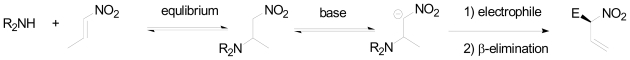
Intermolecular cross-double-Michael addition facilitated by amines via β-elimination.